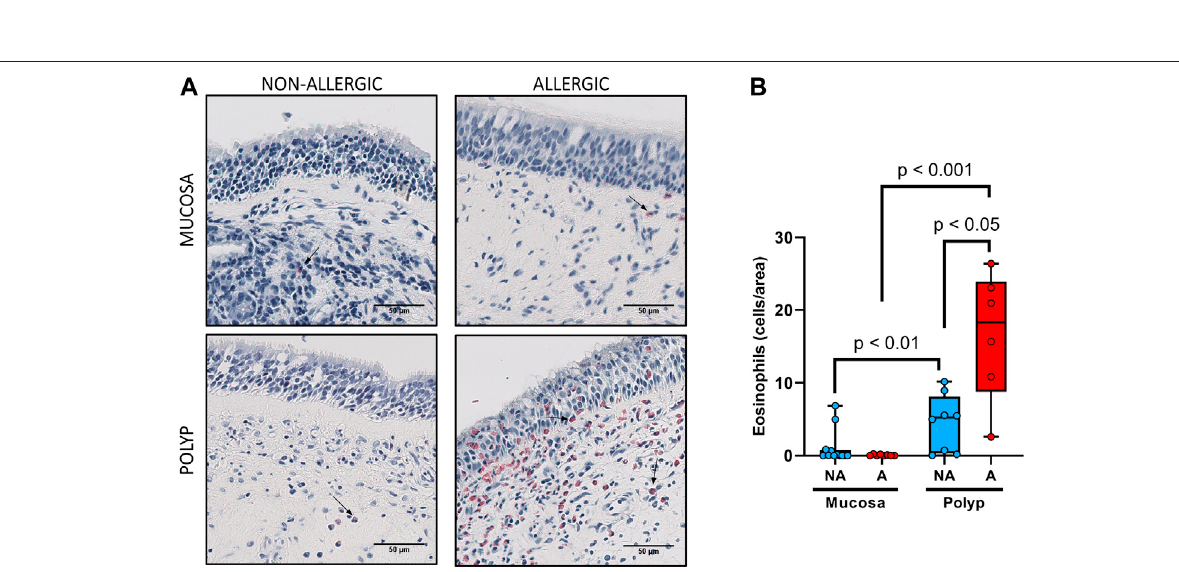
FIGURE 3 | Trajectories of representative metabolites in non-allergic CRSwNP (blue), and allergic CRSwNP (red) patients in plasma and nasal polyp samples. The median is indicated by the discontinuous line within the violin plot, and each sample ’ s value is shown individually.